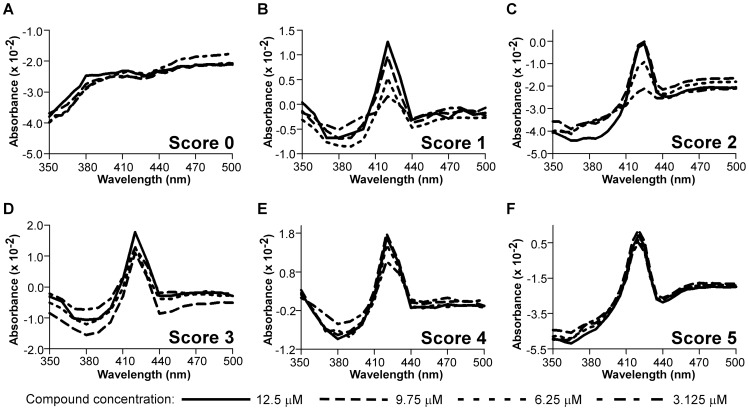
Scoring positive hits in spectral mode.Absorbance was monitored at four serial dilutions for each tested compound. (A) Lack of characteristic spectra-score 0; (B) concentration dependence with no spectra overlap – score 1; (C) any two spectra overlap-score 2; (D) any three spectra overlap-score 3; (E) three highest concentrations overlap-score 4; (F) all four spectra overlap-score 5.